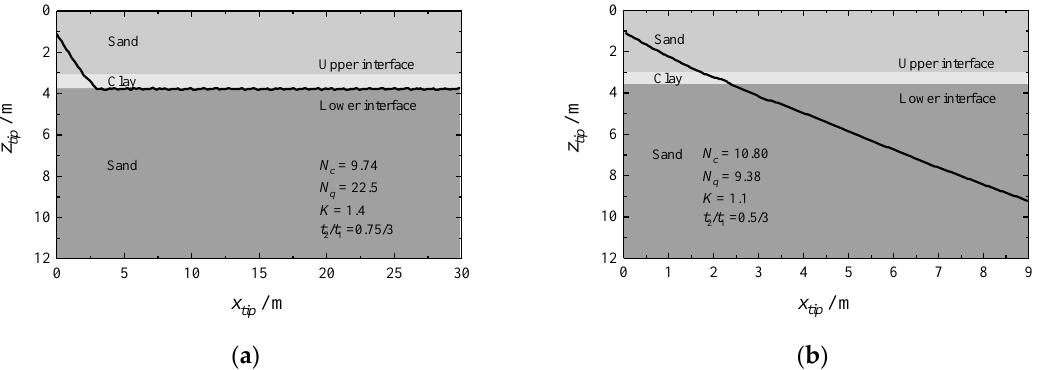
Figure 16. Trajectories in sand-clay-sand layers [17]: ( a ) Case 1; ( b ) Case 2.